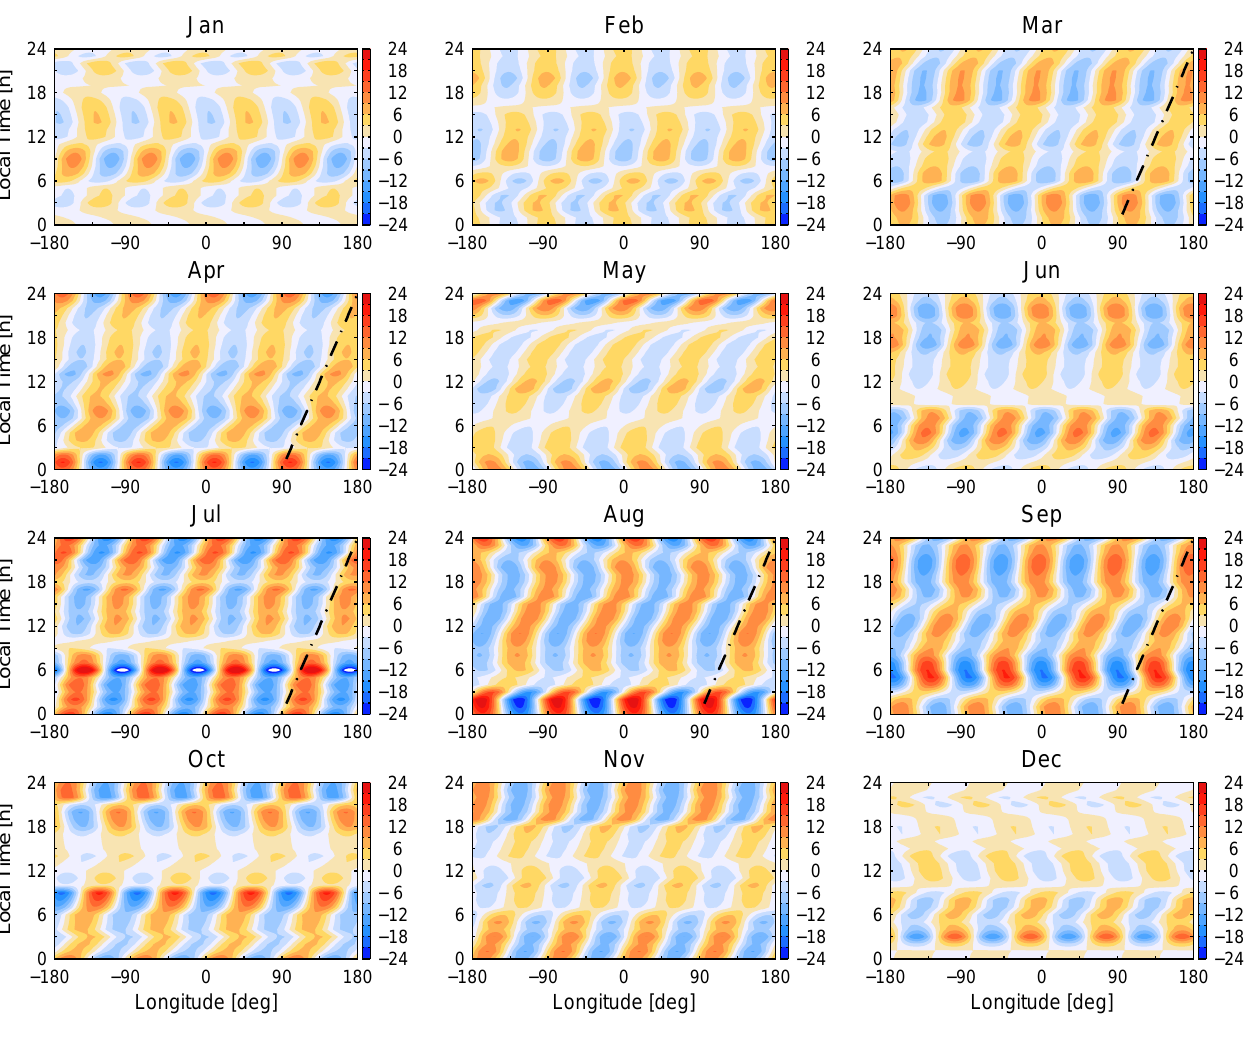
Fig. 2. Longitude vs. local time distribution of the observed wave-4 structure in the zonal wind [m/s] for each month of the year. The black guiding line is indicating a phase propagation of 90 ◦ to the east within 24h